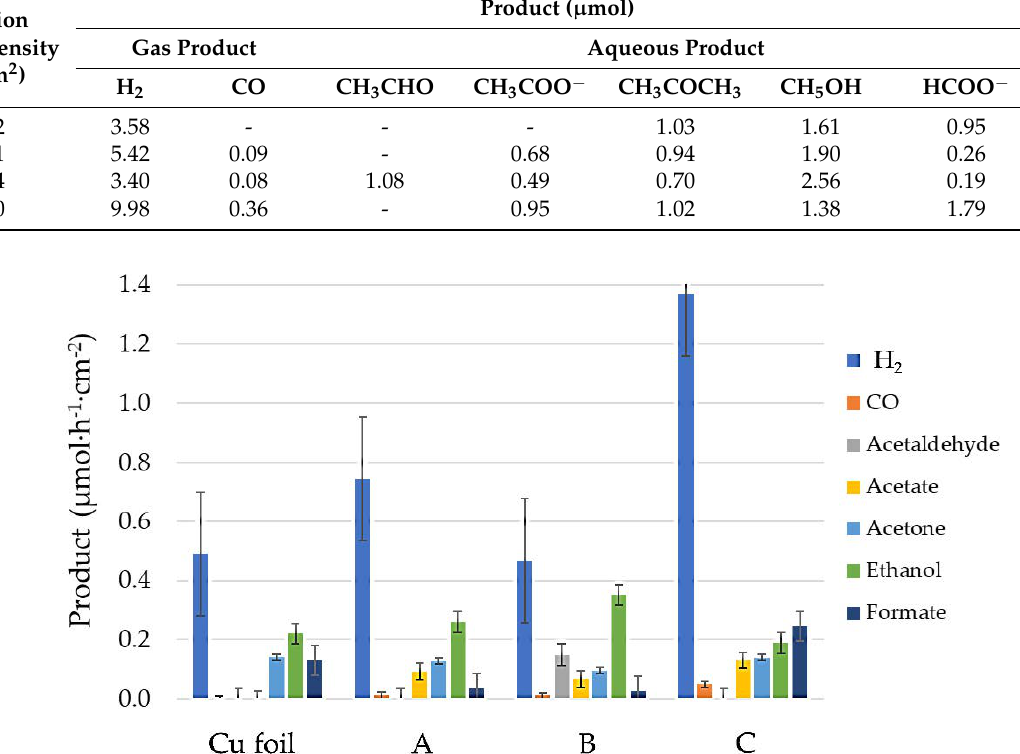
Figure 7. Rate of production of the chemical products of CO 2 RR obtained from different groups of Cu electrodes, Cu foil and the porous Cu electrodes from groups A, B, and C, electrodeposited with 3 A/cm 2 for 40 sec.